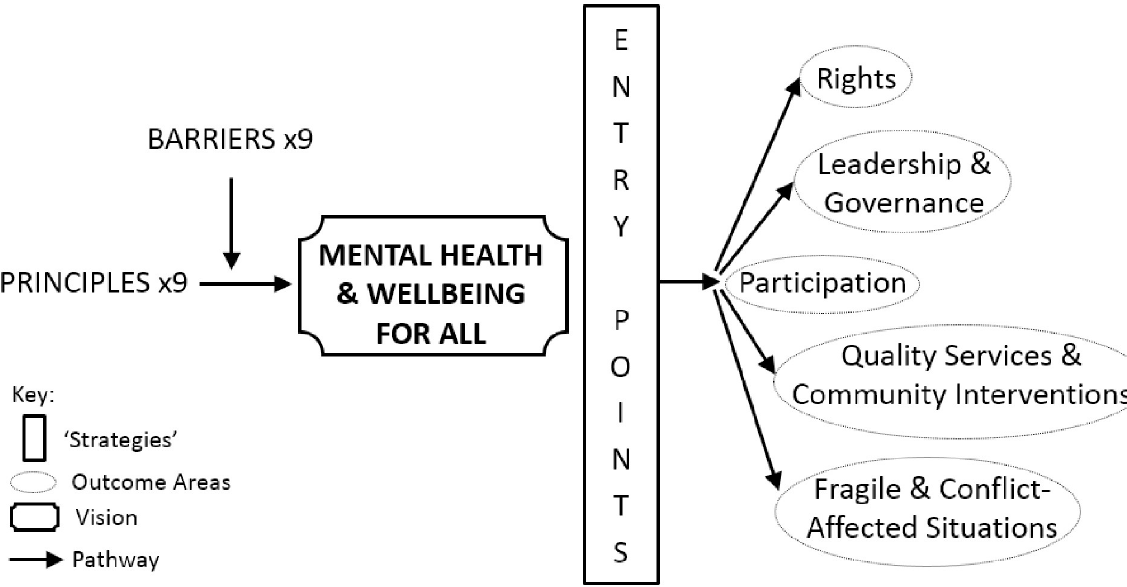
Fig 2. Theory of change to support global development actors deliver mental health support (from DFID, 2020).